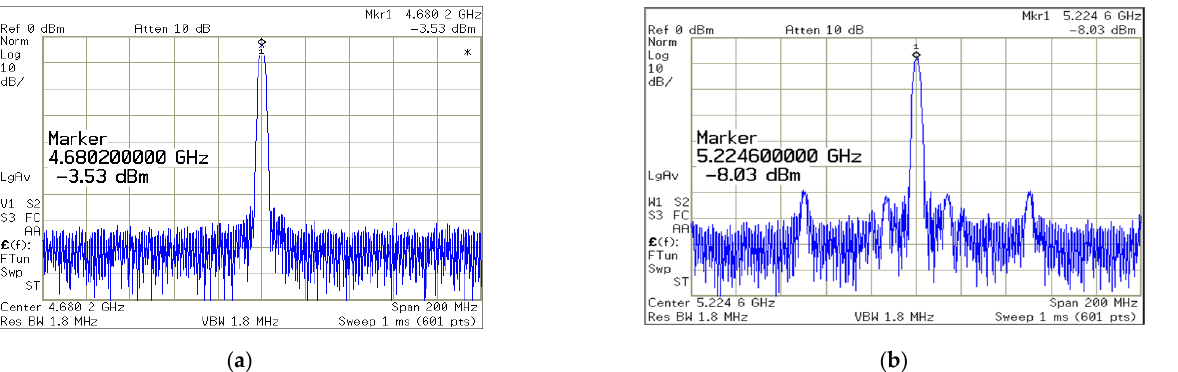
Figure 9. The proposed measured output spectrum ( a ) free-running DCO; and ( b ) phase-locked synthesizer with reference spur of 52 dB.